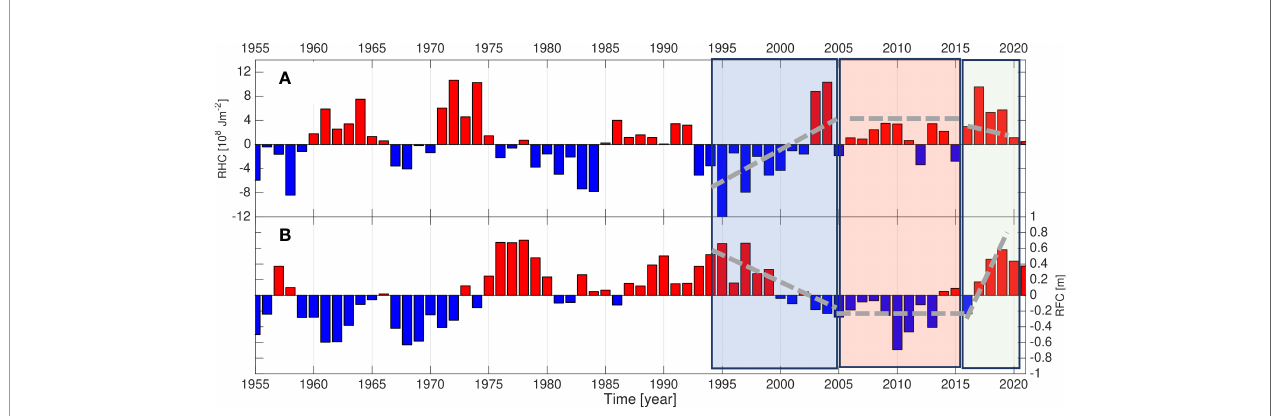
FIGURE 2 | (A, B) Time series of Relative Heat Content (RHC) and Relative Freshwater Content (RFC) in the Norwegian Basin (after Mork et al.,